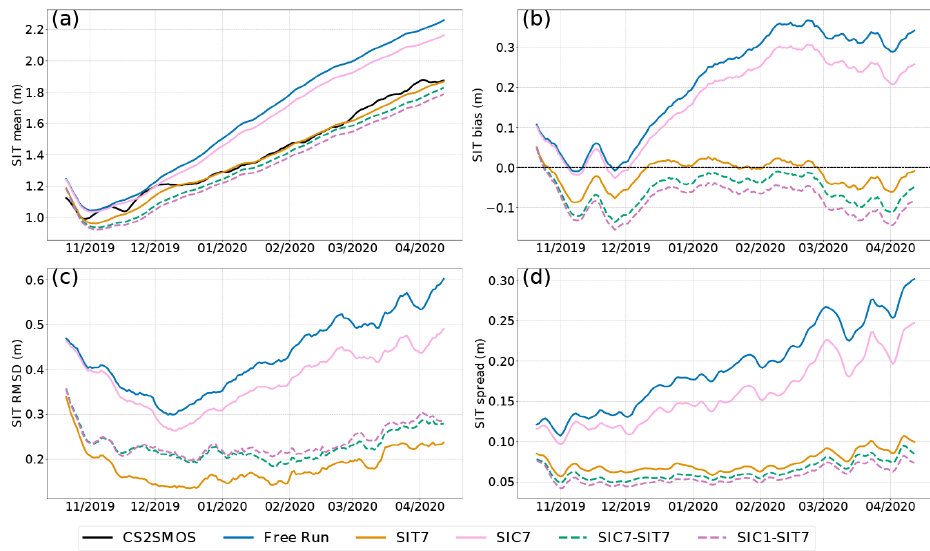
Figure 6. Time series of spatially averaged SIT from the model forecast against CS2SMOS from 18 October 2019 to 16 April 2020. (a) Ensemble mean SIT; (b) bias; (c) RMSD; (d) ensemble spread (standard